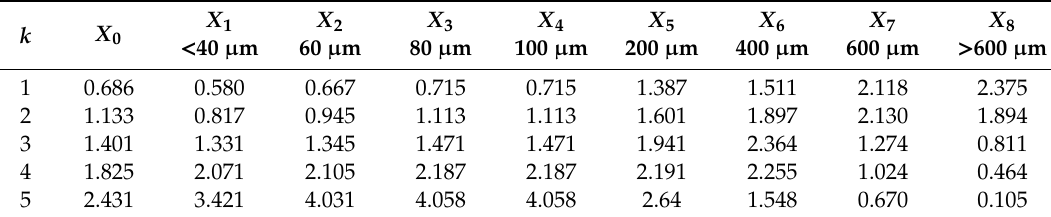
Table 6. Results of average sequences.